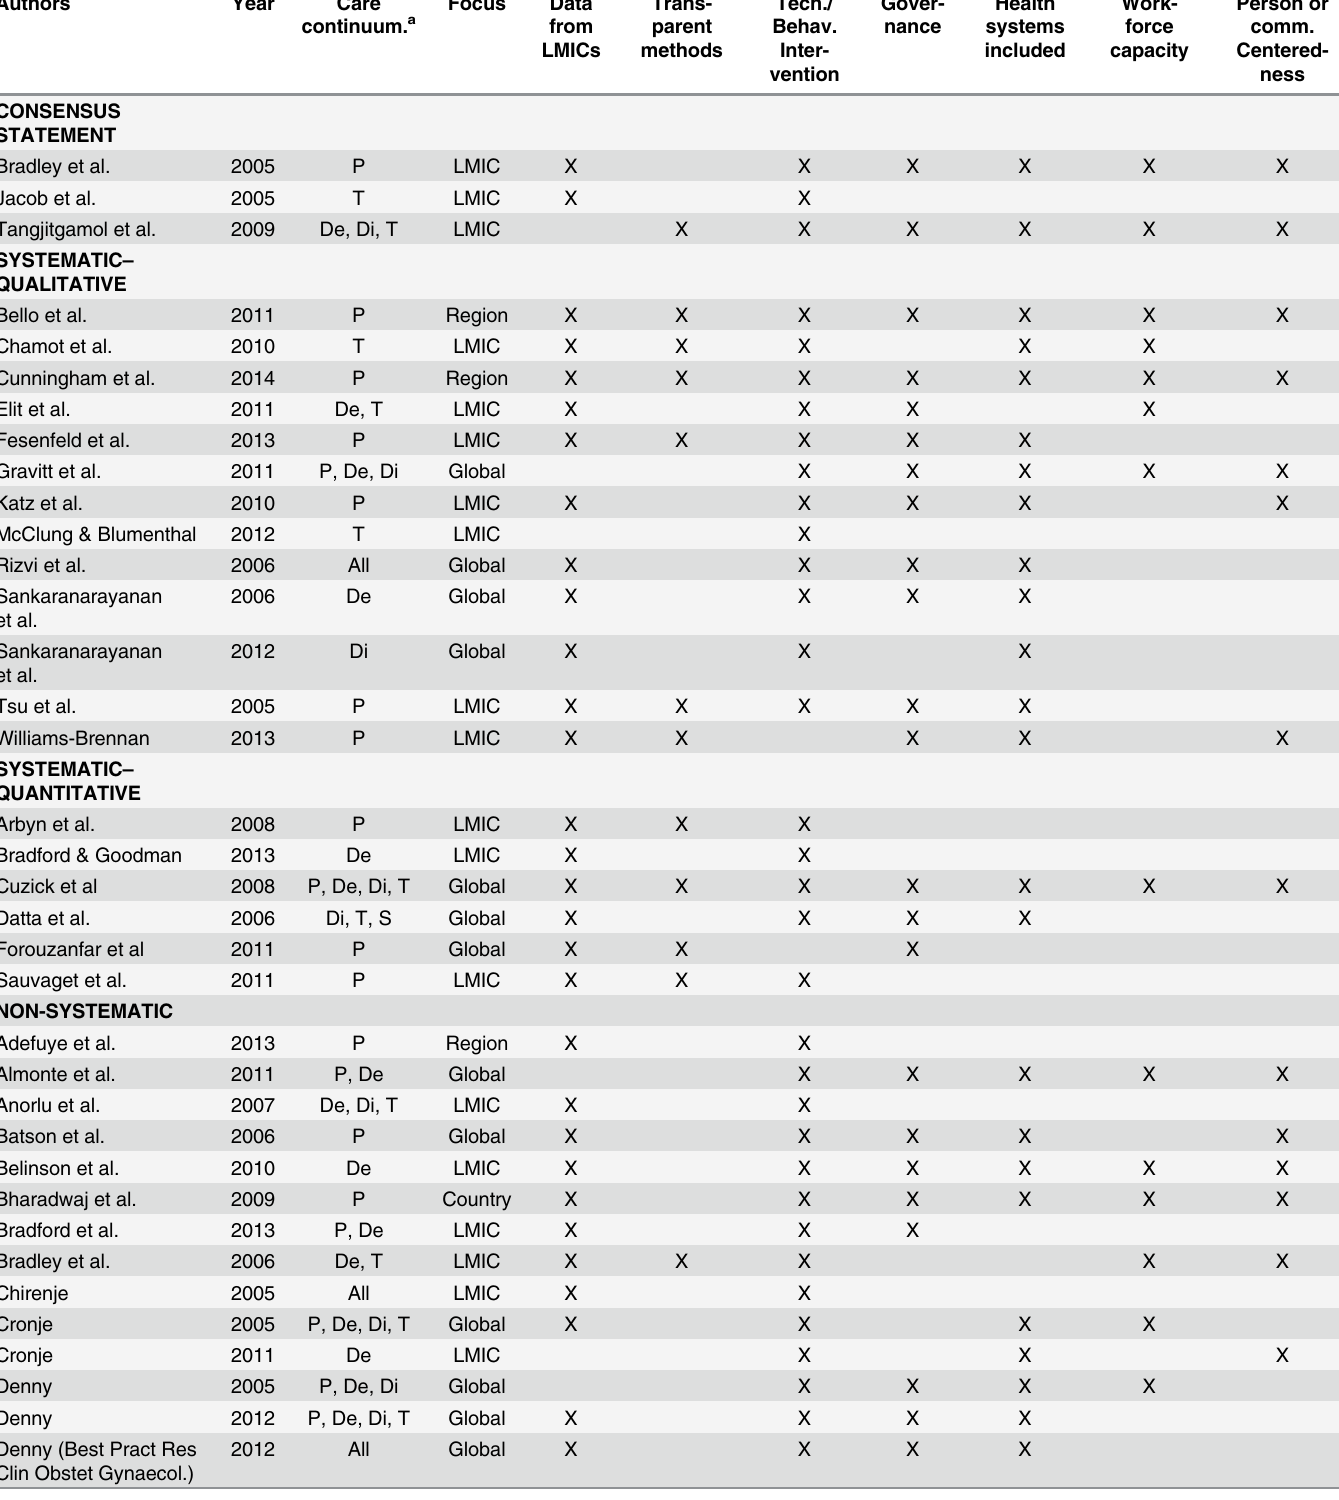
Table 4. Reviews of cervical cancer in low- and middle-income countries (LMICs). Authors Year Care